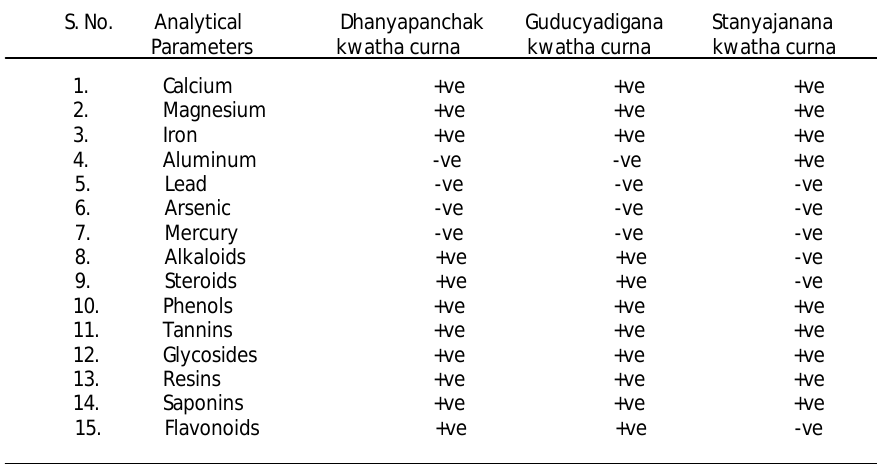
Table 2. Qualitative inorganic and orgarinc analytical data of kwatha curnas S. No.